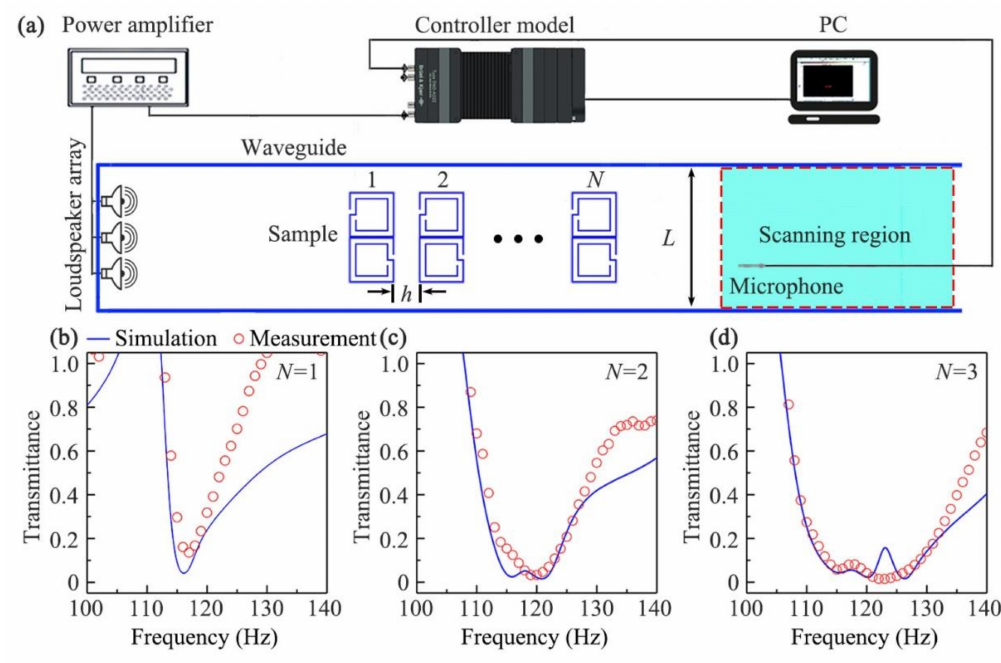
Figure 6. ( a ) Measurement set up. Simulated (blue solid line) and measured (red open circles) transmittance spectra through the sample composed of N -layer units in the waveguide, and the corresponding layer number: ( b ) N = 1; ( c ) N = 2; ( d ) N =